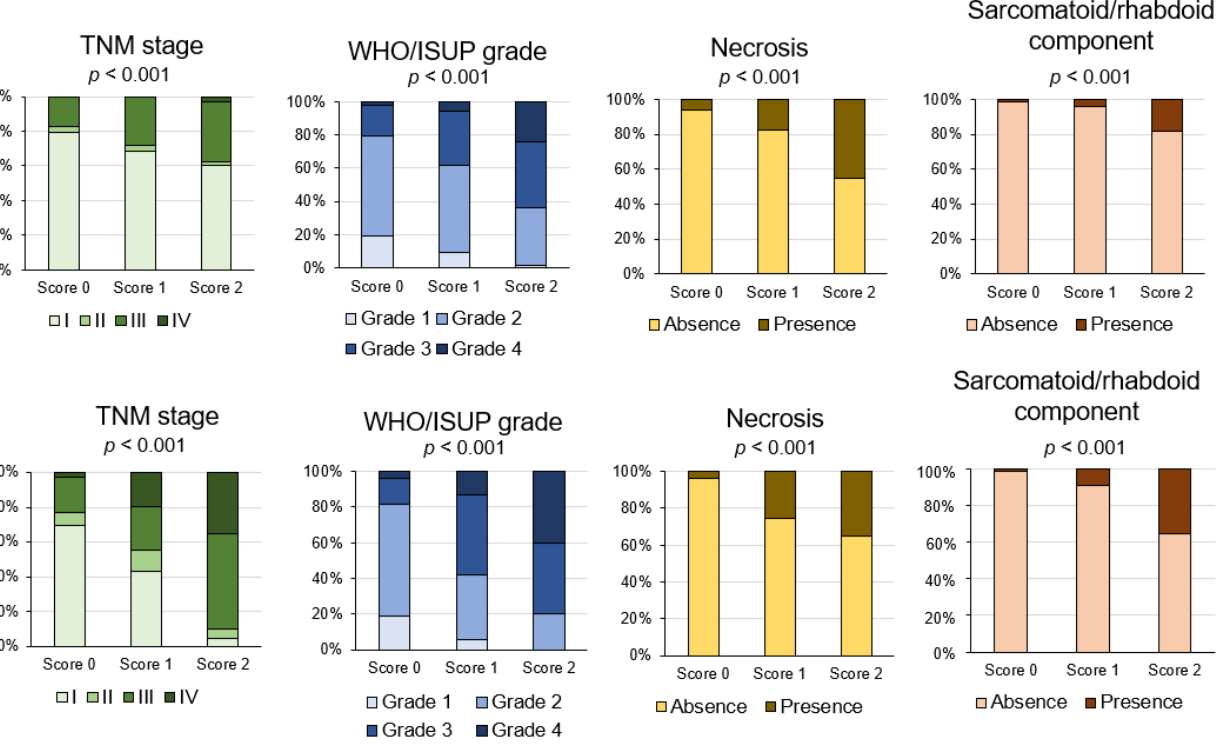
Figure 8. Association of inflammation score with pathological prognostic factors in the principal cohort ( A ) and the TCGA-KIRC cohort ( B ). Percentage of cases of each inflammation score and pathological prognostic factor.